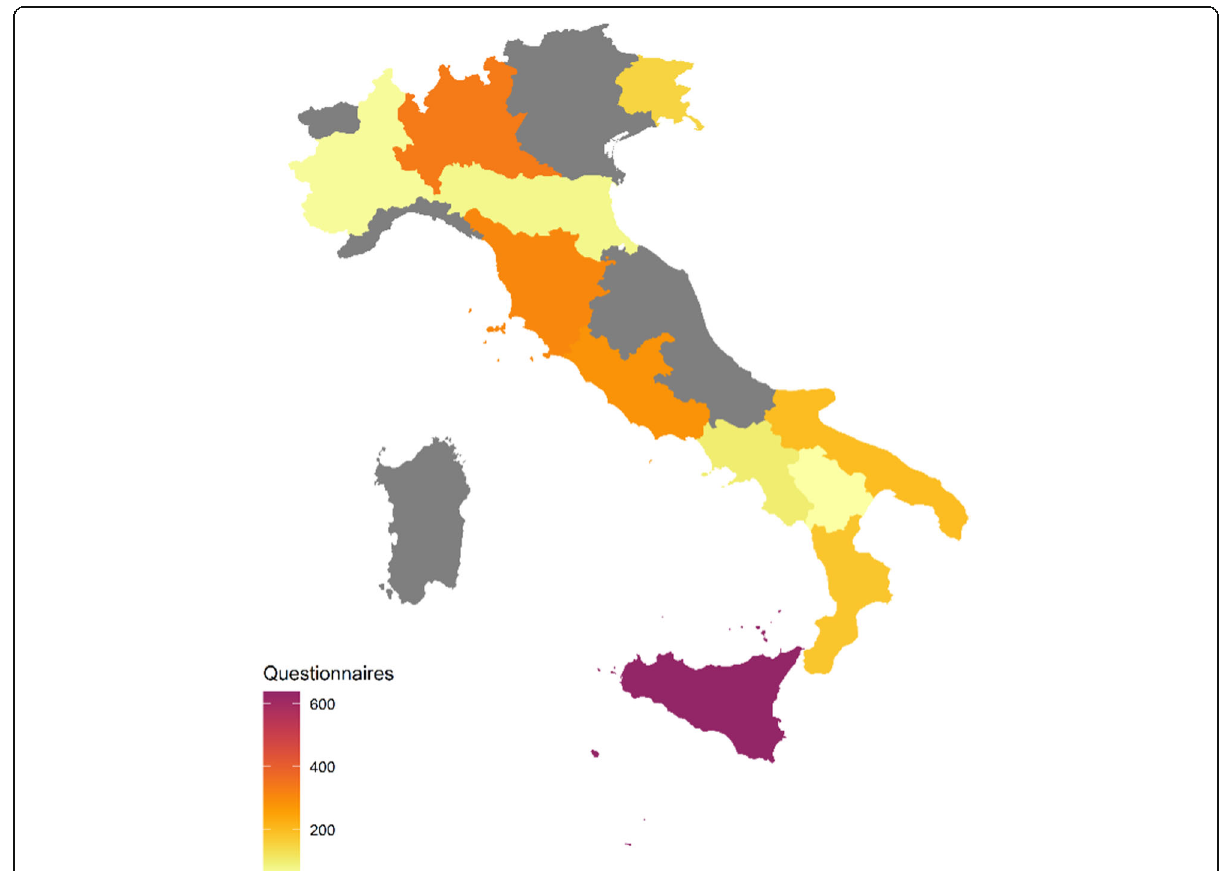
Fig. 1 Geographical distribution of the centres in Italy and a colour legend reporting data on the number of provided